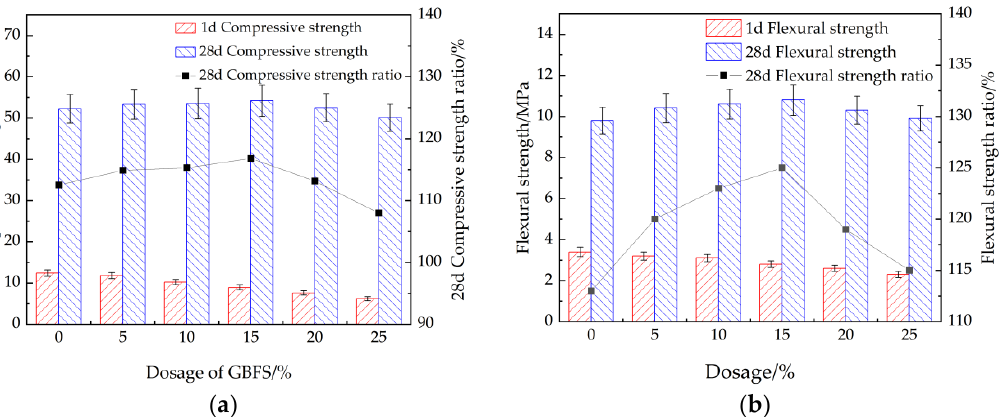
Figure 7. The mechanical strengths of cement mortar with BFS. ( a ) Compressive strength, ( b ) flexural strength.